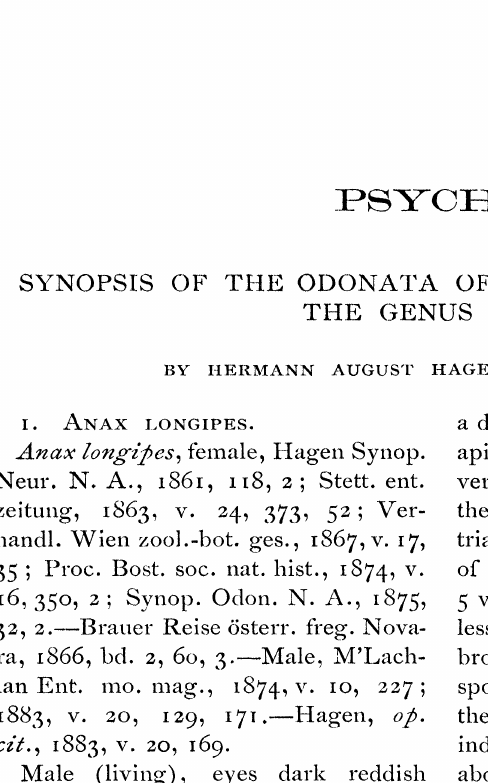
black, femora yellow, the articulation with the tibiae and the inside of the anterior femora black;posterior tibia e ram. legs reaching beyond the fourth seg- ment; abdomen with the two basal segments inflated, green; first segment with two brown spots on the basal thoracical impression;second segment with a transversal (lark median